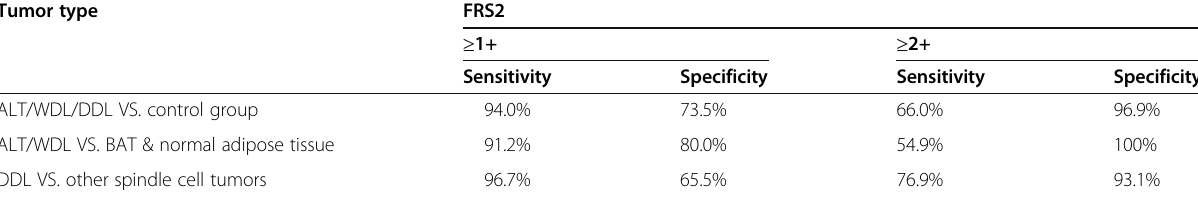
Table 3 Sensitivity and specificity of FRS2 immunostaining in diagnosing ALT/WDLs and DDLs Tumor